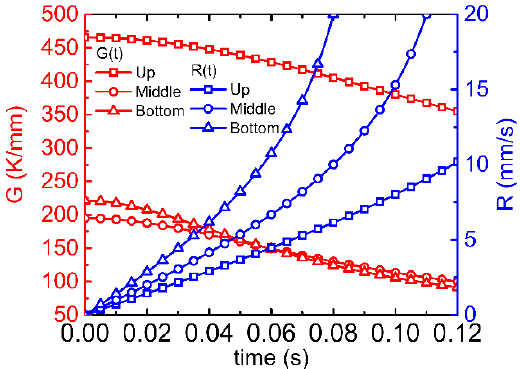
Figure 11. Transient thermal conditions, i.e., transient temperature gradient G and transient solidi- fication rate R , during solidification of laser welding pool calculated by Equations (3) and (4) using the parameters obtained from heat transfer simulation results.